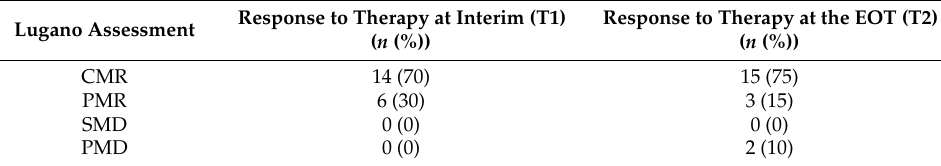
Table 3. Results of response to therapy according to Lugano assessment. Reported data are number of patients and percentages are in parenthesis.